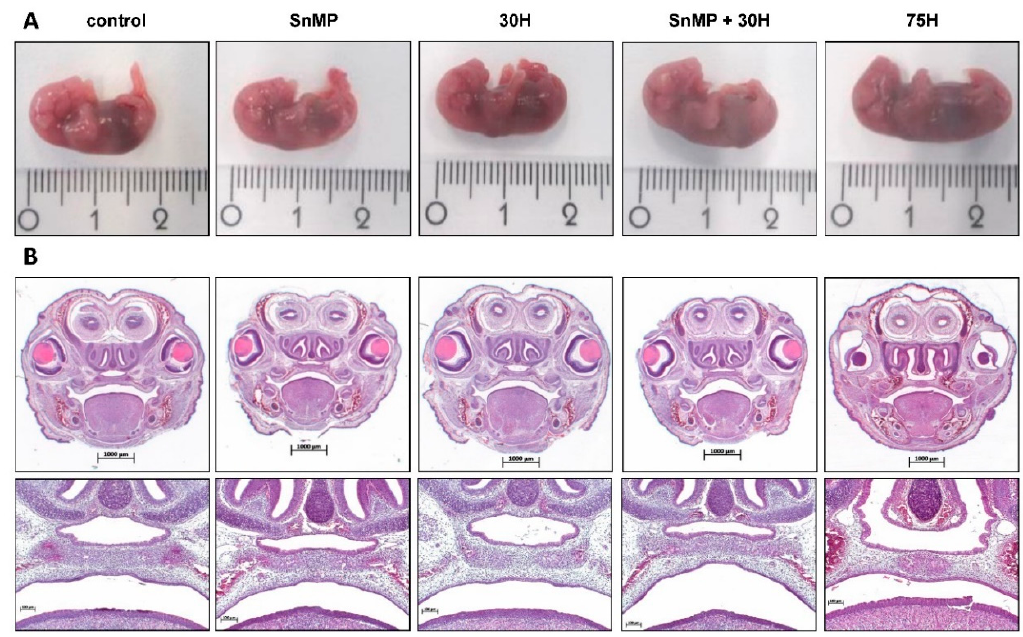
Figure 3. Palatal fusion despite inhibition of HO-activity and heme administration. ( A ) A representative fetus per group is shown: fetus control, 1.96 cm, 659.5 mg; fetus SnMP, 1.94 cm, 846.3 mg; fetus 30H, 1.95 cm, 832.3 mg; fetus SnMP + 30H, 1.69 cm, 654.1 mg; fetus 75H, 2.43 cm, 1125.9 mg (centimeter ruler). ( B ) The palatal sections were classified into four stages of palatogenesis based on the anatomy of the palatal shelves: elevation, horizontal growth, midline adhesion and fusion.